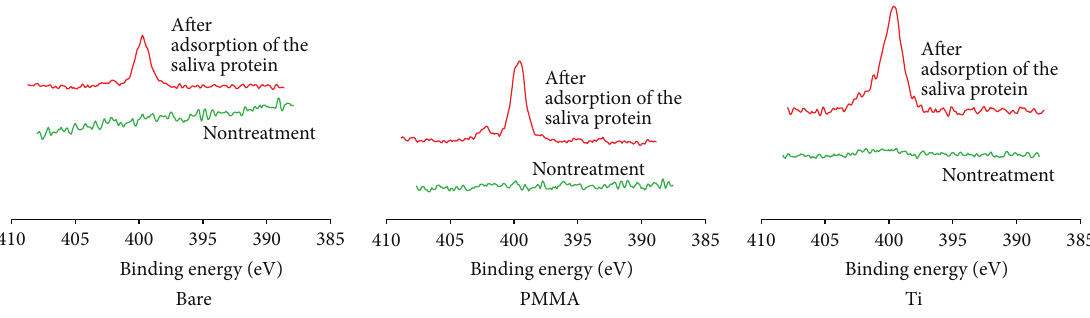
Figure 11: XPS analysis after adsorption of BSM. N1s XPS spectra for BSM adsorbed onto bare, PMMA, and Ti QCM sensors. N1s XPS spectra before (green) and after (red) adsorption for